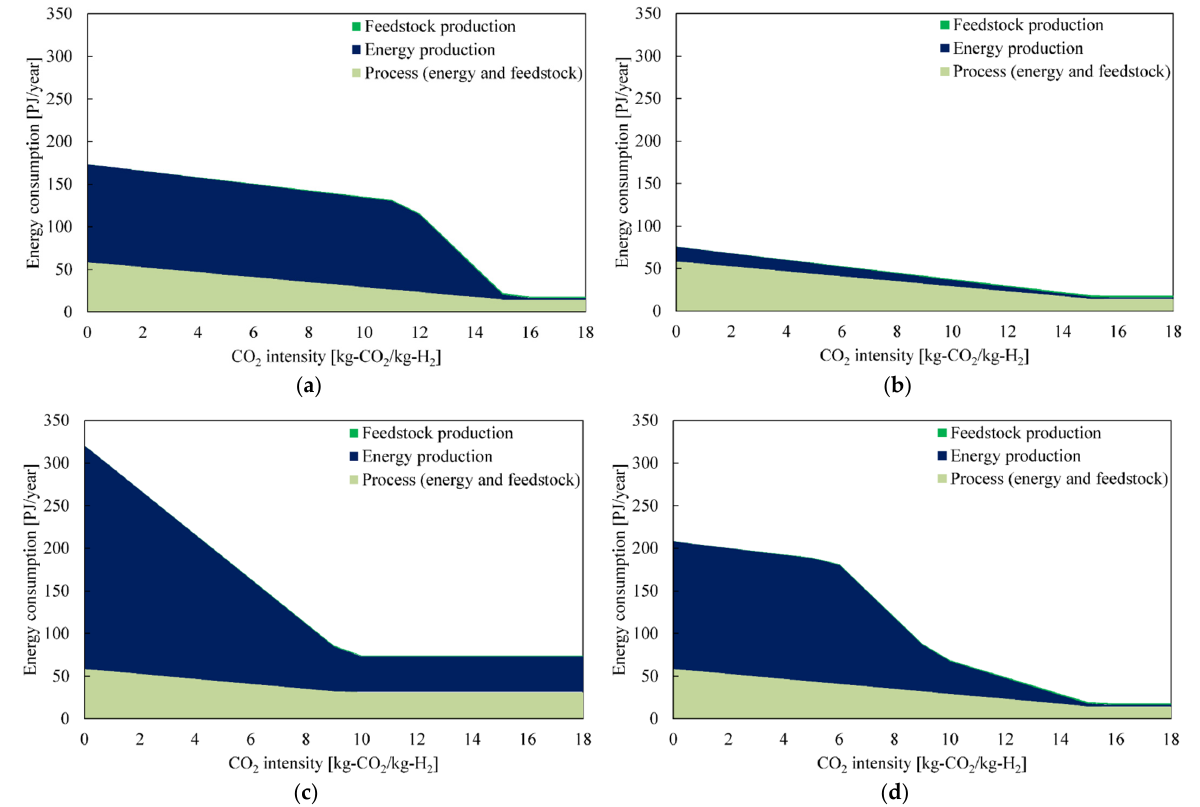
Figure 5. Energy consumption as function of the CO 2 intensity for hydrogen production on a cradle- to-gate basis. ( a ) Low-Cost scenario; ( b ) Low Energy Use scenario; ( c ) Water-Energy-Carbon scenario; ( d ) Water-Energy-Carbon-Cost scenario.